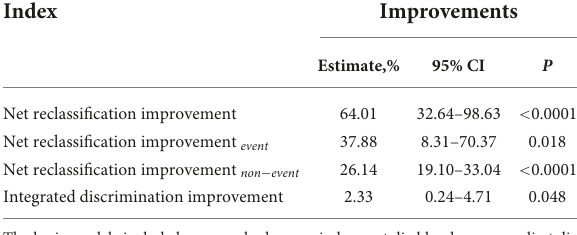
TABLE 3 Improvements in risk discrimination and reclassification for all-cause mortality upon addition of urinary matrix Gla protein